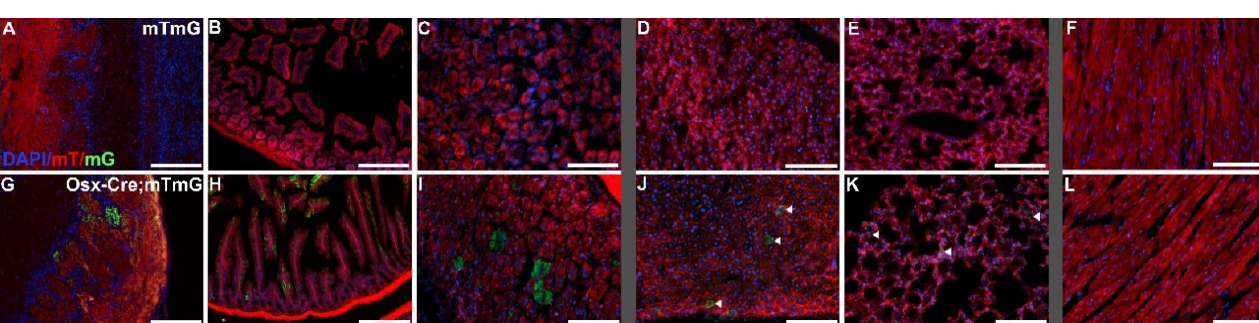
Figure 2. Demonstration of Cre recombinase activity driven by the Osterix-GFP-Cre promoter. Select organ sections of Osterix-Cre-;ROSA26mTmG mice (mTmG; ( A – F )) and Osterix-Cre+;ROSA26mTmG mice (Osx-Cre;mTmG; ( G – L )) showing fluorescence of membranous tdTomato (mT) in the absence of Cre recombinase activity and membranous EGFP (mG) in the presence of Cre recombinase activity. Widely expressed off-target Cre recombinase was confirmed in the olfactory bulb glomerular layer ( G ), the intestine ( H ), and the stomach ( I ). Sparse off-target Cre recombinase expression was seen in the liver ( J ) and the lungs ( K ), designated by arrows. No Cre recombinase activity was present in the heart ( L ). Scale bars ( A , B , G , H ) = 200 µm. Scale bars ( C , F , I , L ) = 100 µm.